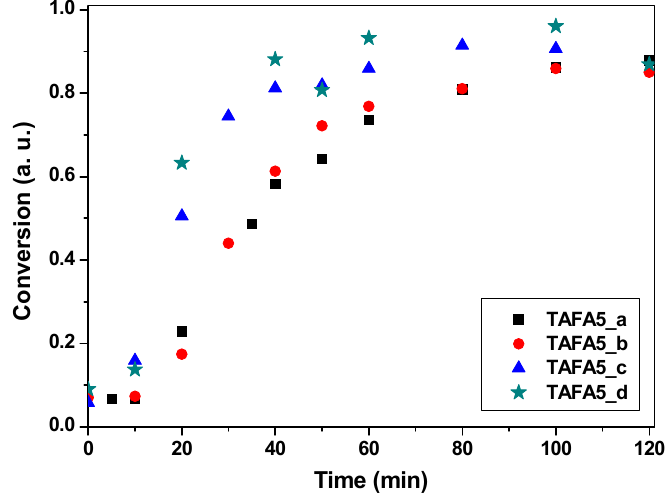
Figure 2. Polymerization conversion profiles for the latexes synthesized with 35 g of methyl methacrylate (MMA), 2.5 g of acrylated fatty acids (AFA), and 12.5 g of vinyl pivalate (VPi), and potassium persulfate (KPS) concentrations equal to 0.5 g ∙ L − 1 (TAFA5_a), 0.70 g ∙ L − 1 (TAFA5_b), 1.3 g ∙ L − 1 (TAFA5_c) and 2.2 g ∙ L − 1 (TAFA5_d).